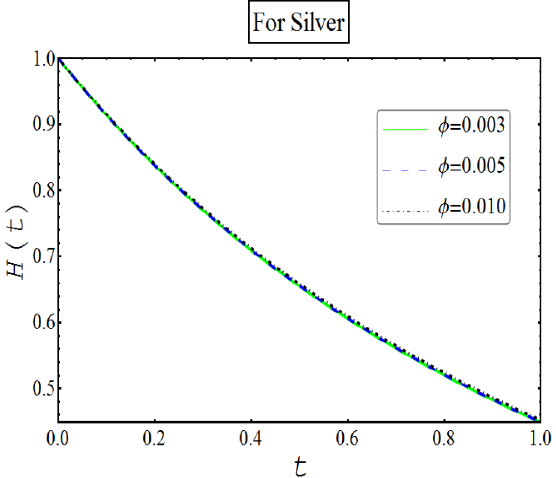
Figure 7. Effects of the concentration of particles on film thickness for the case of silver.